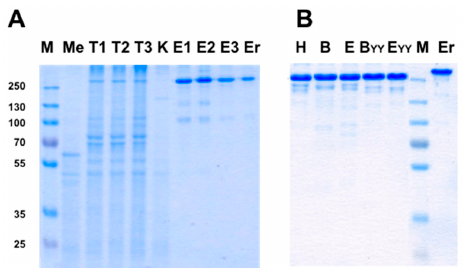
Figure 11. Analysis of the bsAbs produced in Expi293™ mammalian cells by SDS/PAGE. ( A ) 3 Analysis of the bsAbs produced in Expi293™ mammalian cells by SDS/PAGE. independent transfections used to produce a bsAb with an WT T427 Fab arm and an engineered anti CD24 Fab arm (the anti CD24 antibody is a humanized IgG1-Kappa). Me, conditioned medium of untransfected cells; T1, T2, T3 are day 6 conditioned media from 3 transfections. K, KappaSelect unbound fraction; E1, E2, E3 are the bsAbs eluted from the KappaSelect column. Er, Erbitux (used as a full-size IgG protein marker); ( B ) bsAbs identical to those described in Table 3 above. 2.5 µg of each